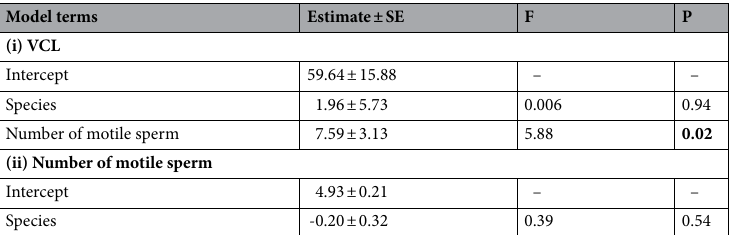
Model terms Estimate ±